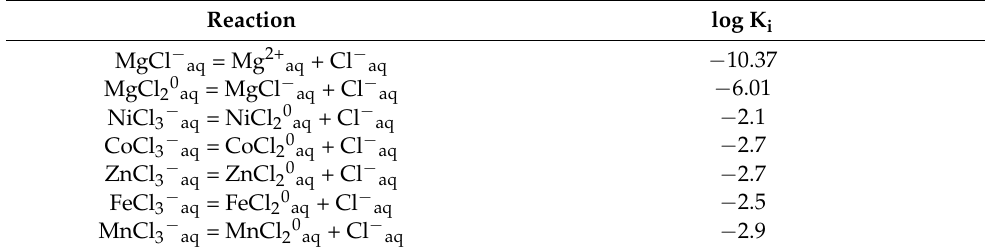
Table 3. Dissociation constants (K i ) at 700 ◦ C and 100